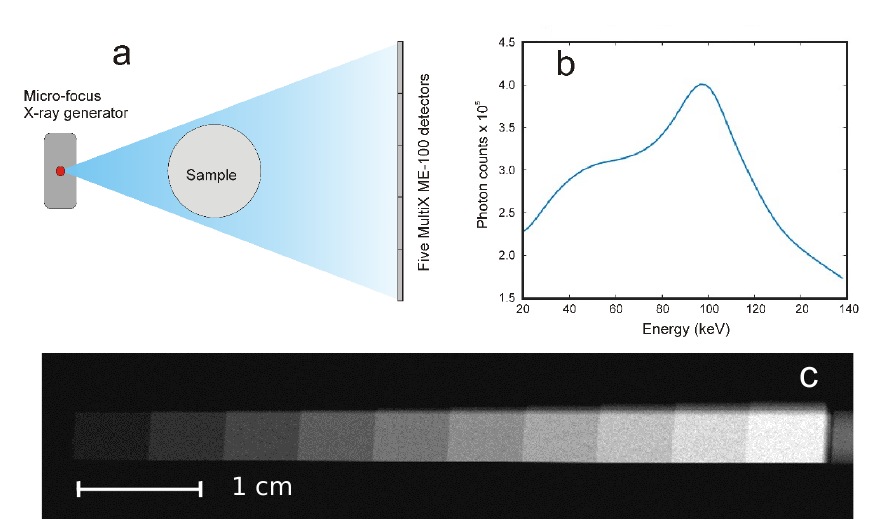
Figure 1. The CT setup ( a ), the experimental 83.6 keV X-ray spectrum as recorded by the MultiX ME-100TM detector ( b ) and a 83.6 keV experimental image of the PET test piece ( c